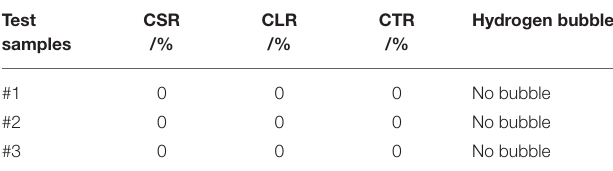
TABLE 2 | HIC performance tests of CB10 steel.